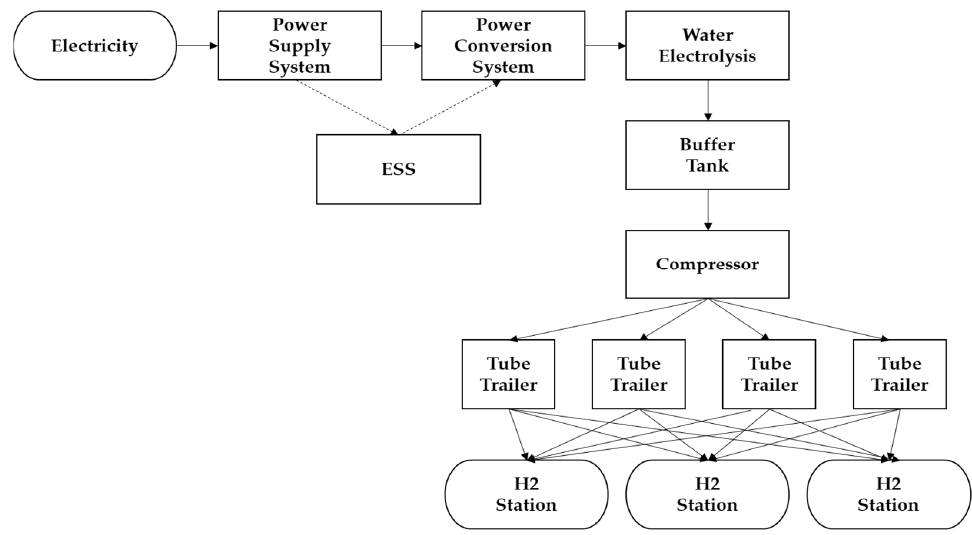
Figure 1. Flowchart of the hydrogen production process through water electrolysis.